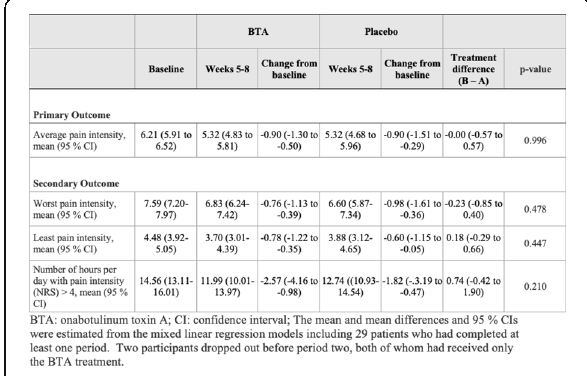
Fig. 1 (abstract P283). Pain severity outcomes and number of hours in BTA versus placebo group at baseline and at weeks 5-8